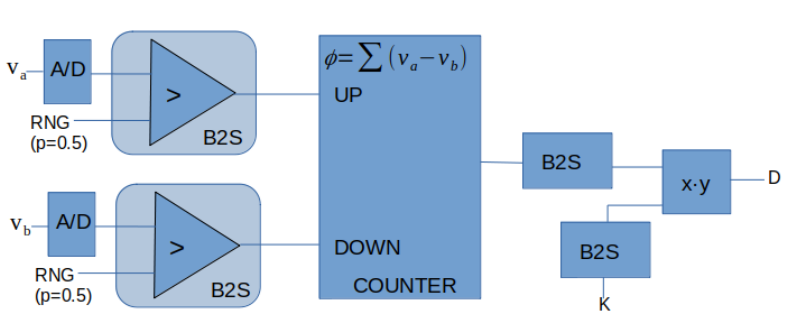
Figure 5. Control block implementation using stochastic